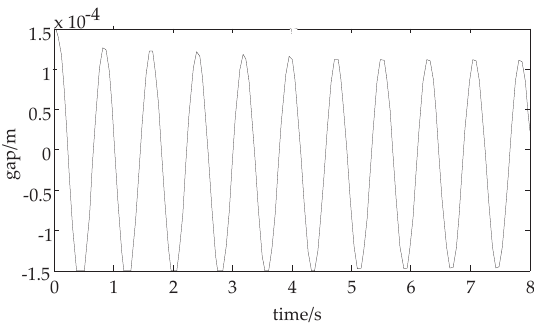
Figure 3. The suspension displacement curve with self-excited